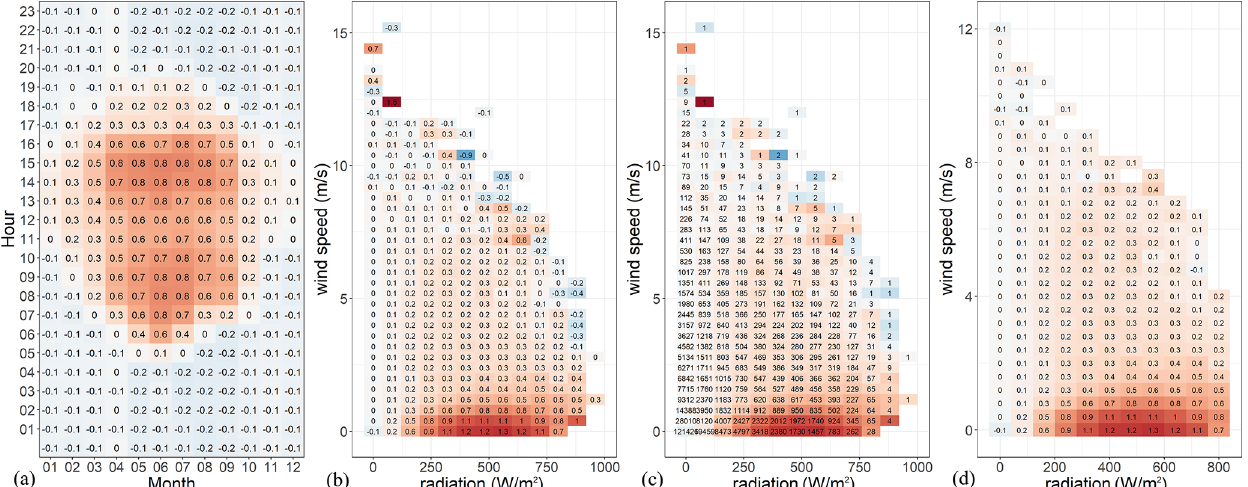
Figure 4. Temperature bias ( ◦ C) as a function of hour of the day and month of the year for all LC-R stations (a) ; temperature bias ( ◦ C) as a function of radiation and wind speed for all LC-R stations (b) ; temperature bias ( ◦ C) as a function of radiation and wind speed for all LC-R stations, where the values written in each cell signify the sample size (c) ; and temperature bias ( ◦ C) as a function of radiation and wind speed for all LC-R stations, where cells with a sample size lower than 10 are not shown in the graph (d) . Note that the ranges on the y axis differ for the different subplots. Background colours, ranging from blue ( − 1.7 ◦ C) to red (1.7 ◦ C), represent the temperature bias. The temperature bias was calculated for all measurements between the installation date of each LC-R station and December